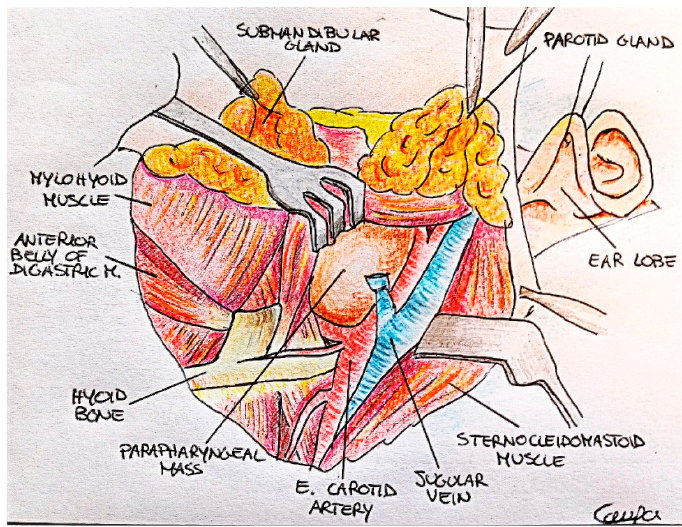
Figure 4. Representation of the operating field. It is evident that by elevating the posterior belly of the digastric muscle (up left retractor) and retracting the sternocleidomastoid muscle (inferior right Farabeuf retractor), it is possible to identify the vascular cervical axis and gain the access to PS. The postoperative course was uneventful. Surgical drainage of the thyroid region was removed 48 h after surgery; surgical drainage of the parapharyngeal and